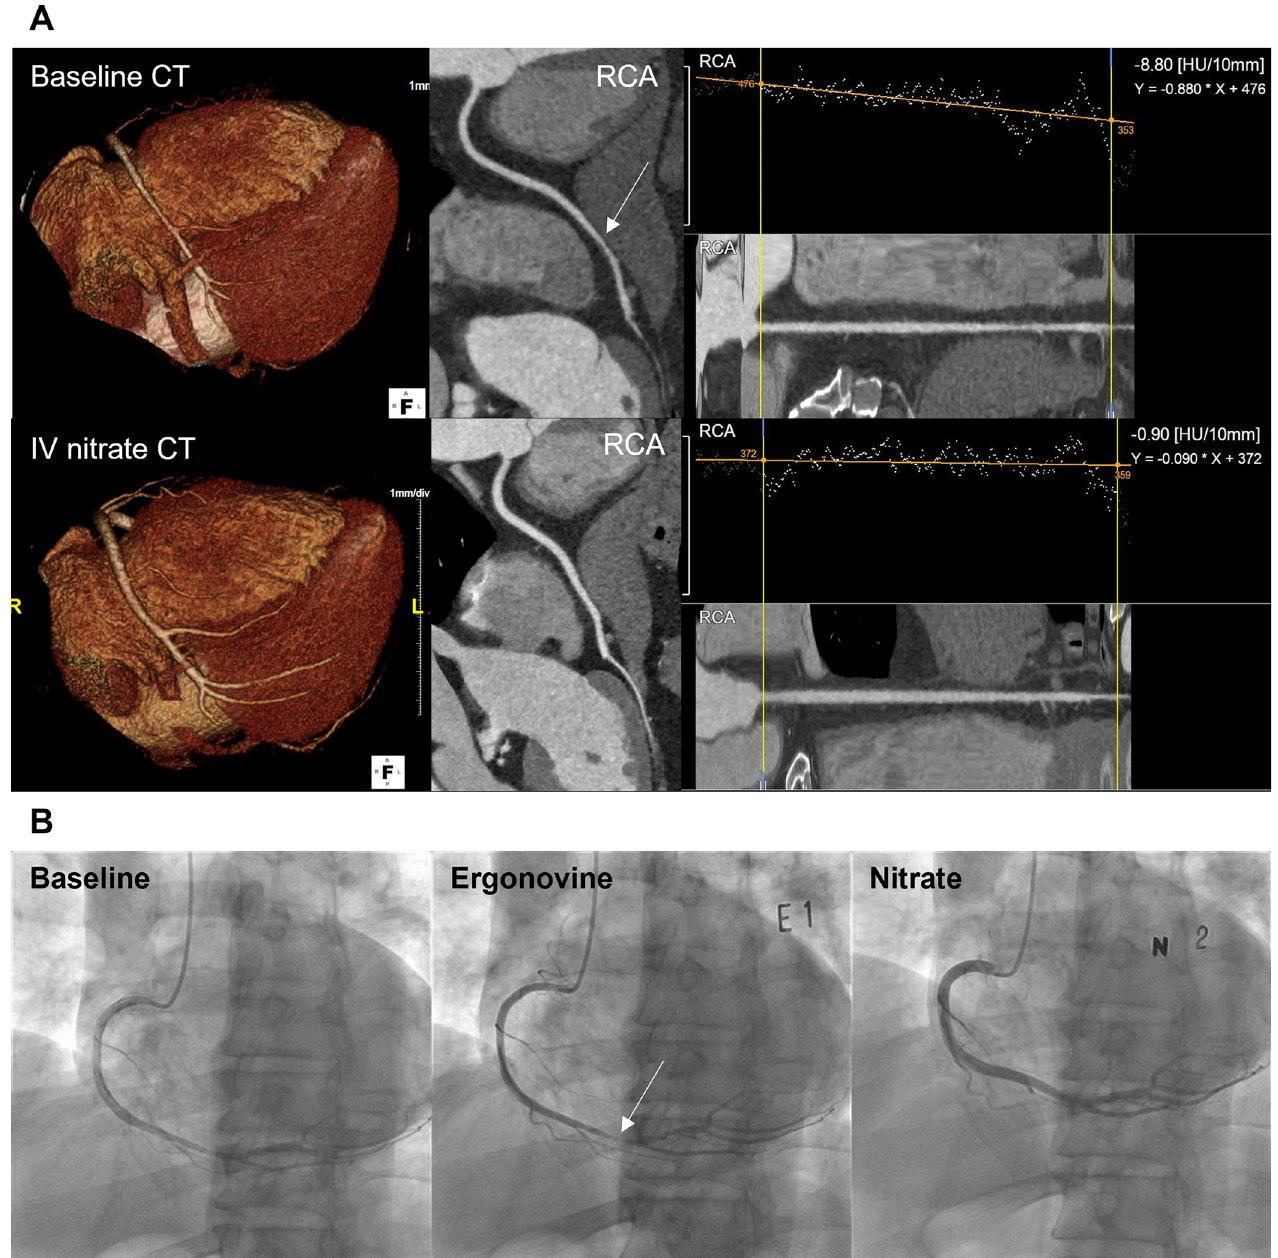
Fig 2. A representative case of the focal-type spasm on CCTA and the ergonovine provocation test. A 59-year-old male patient presented with intractable recurrent chest pain. (A) Baseline CT (upper) revealed significant focal stenosis at the distal RCA on volume rendering and curved multiplanar images. IV nitrate CT (lower) revealed completely dilated coronary arteries without narrowing. (B) Baseline coronary angiography (left) revealed intermediate luminal stenosis of the distal RCA. Upon ergonovine infusion (middle), RCA showed complete luminal occlusion. After nitrate injection, RCA showed full dilation without evidence of a stenotic lesion (right). The TAG values were -8.80 and -0.90 for baseline CT and IV nitrate CT, respectively. CCTA, coronary computed tomography angiography; CT, computed tomography; IV, intravenous; RCA, right coronary artery; TAG, transluminal attenuation gradient. artery were automatically identified and manually modified, if necessary. Cross-sectional images perpendicular to the vessels’ center-line were reconstructed. The mean luminal attenu- ation (HU) was measured at 1 mm intervals, from the ostium to distal levels where the cross-